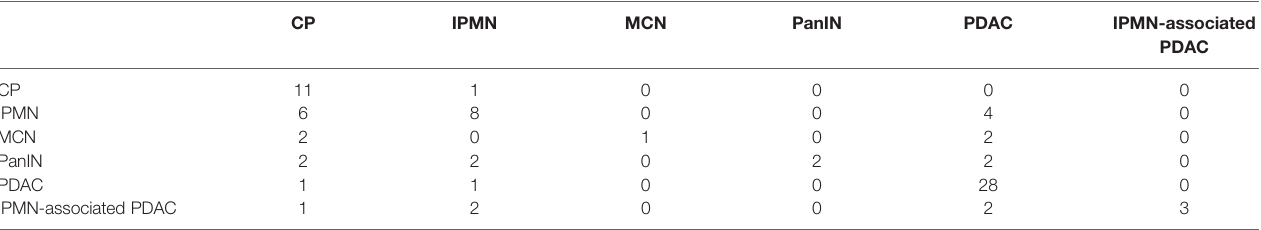
TABLE 3 | The confusion matrix for the multi-class CGAT classi fi er for the six different pancreatic diseases.